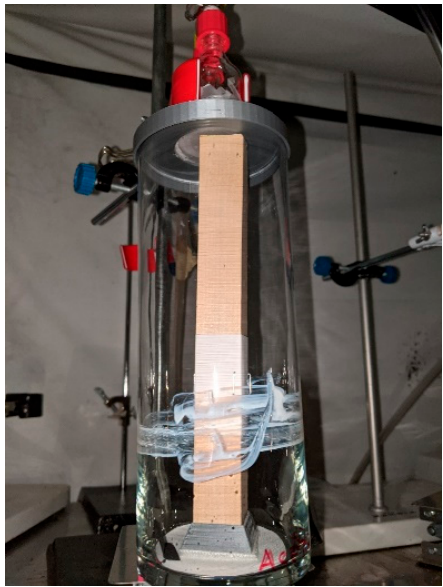
Figure 2. Feeding assay to evaluate responses of bed bugs to essential oil constituent barriers. Bugs needed to cross the treated barrier to take a blood meal.